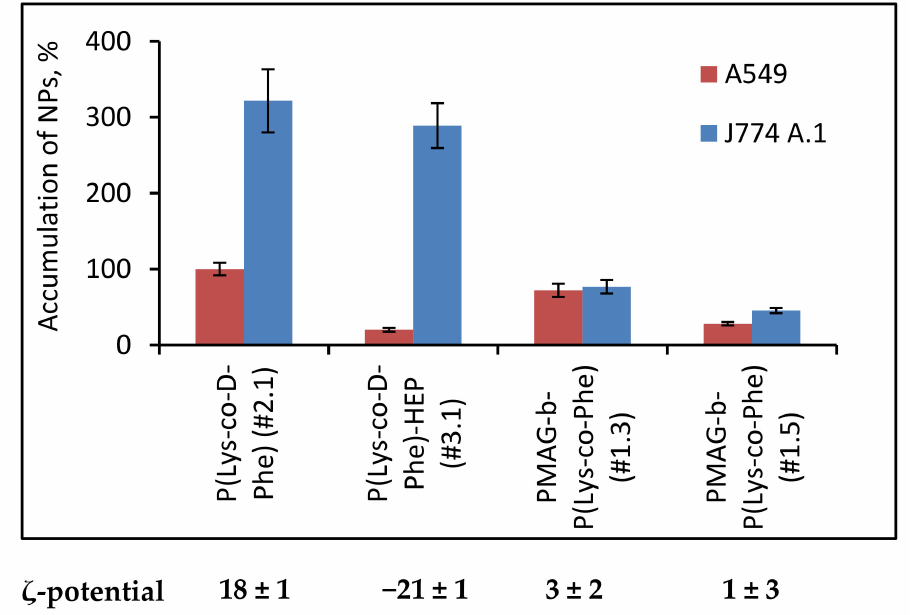
Figure 10. Dependence of NPs accumulation in A549 cells and J774 A.1 macrophages on their composition and surface properties ( C NPs = 25 µ g/mL, C Cy3 = 50 µ g/mg of NPs, t = 24